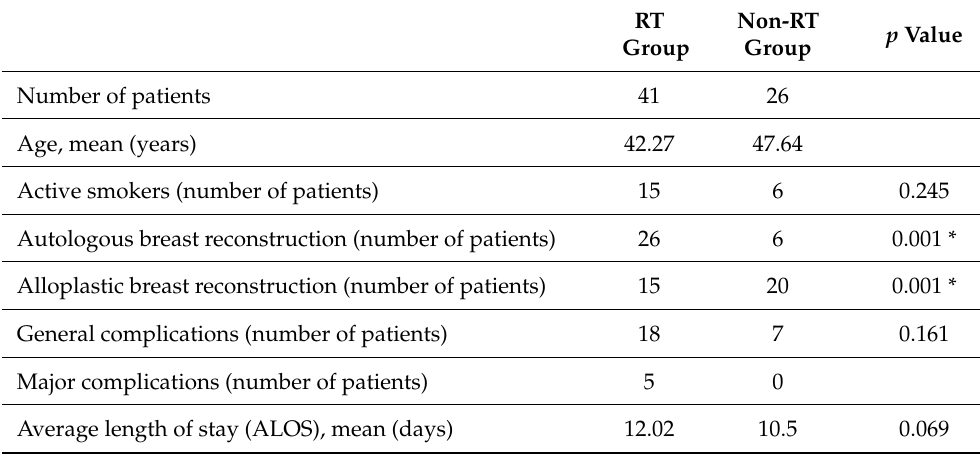
Table 1. Characteristics of RT and non-RT groups in delayed breast reconstruction.